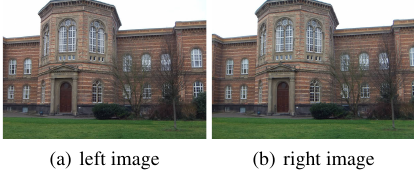
Figure 4: Sample images of the stereo camera data set. Starting from an a priori standard deviation for the image coordi- nates of σ l = 1 pel, the a posteriori variance factor is estimated with (cid:98) s 0 = 0 . 37 indicating the automatically extracted Lowe points to have an average precision of approximately 0.4 pel. The resulting scene points and the poses of the right stereo camera im- ages are shown in Fig. 5.